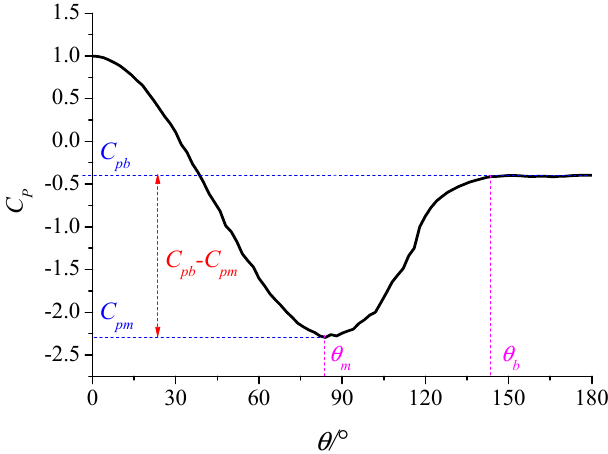
Figure 3. Definition of the characteristic parameters of mean wind pressure coefficients’ distribution curve.